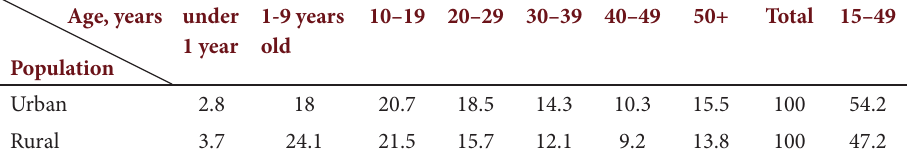
Table 3. Age structure of female population in European Russia, 1897